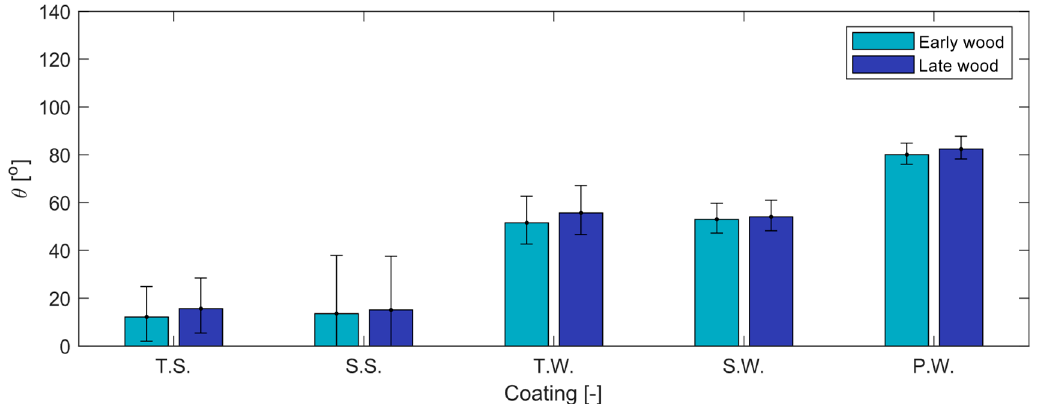
Figure 13. Average coating contact angle for all coatings at t = 1 min.